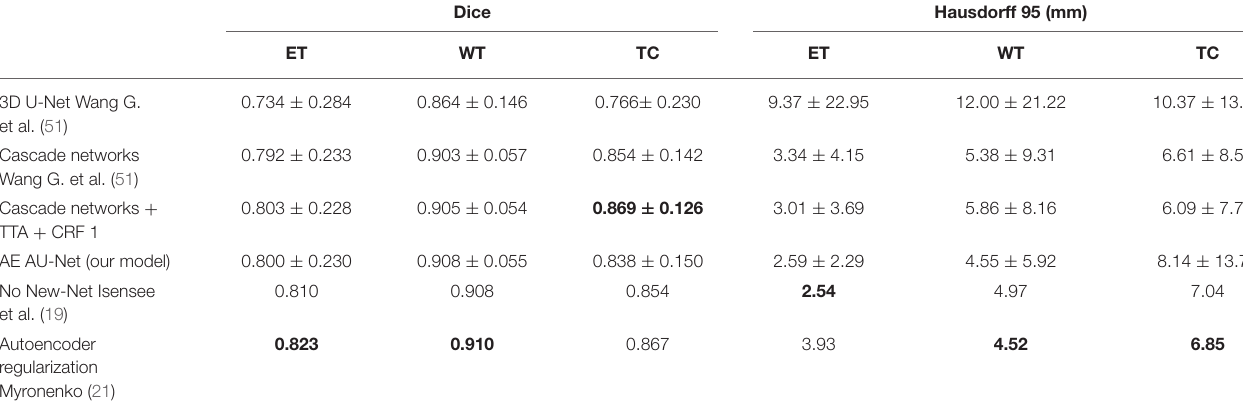
TABLE 3 | Model comparison on BraTS 2018 validation data (66 cases).